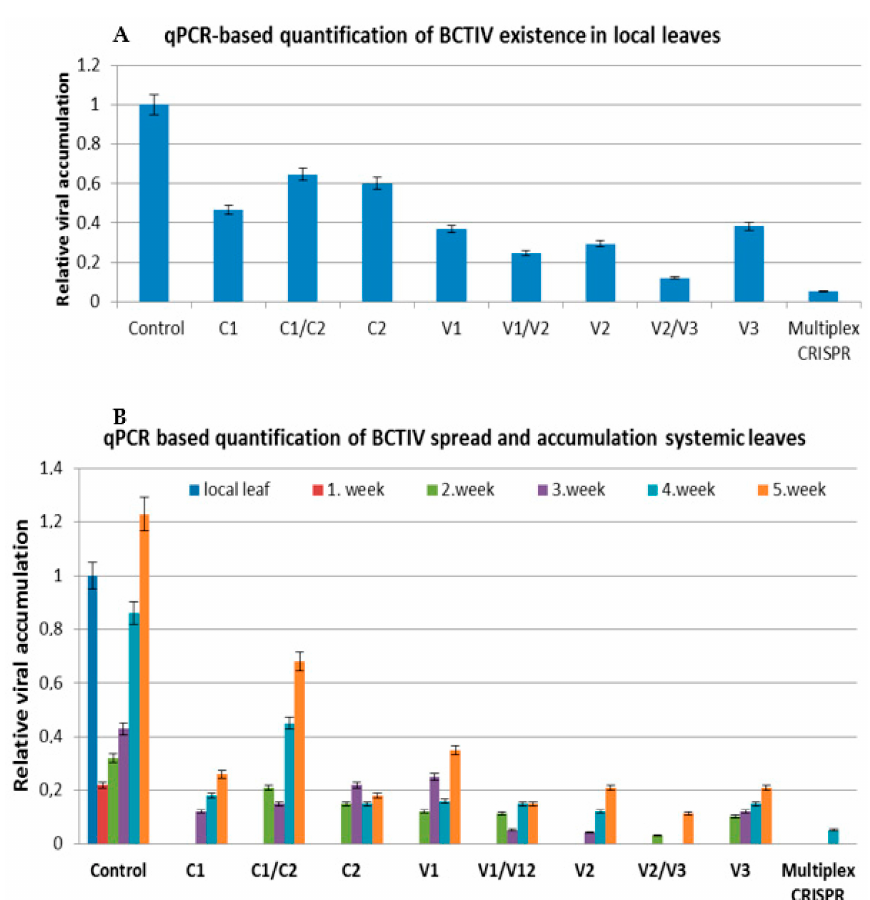
Figure 3. qPCR-based quantification of BCTIV content in gRNA/Cas9 and BCTIV co-agroinoculated local ( A ) and systemic leaves ( B ) in sugar beet. The viral accumulation was quantified according to the viral content of the local leaves in positive control sugar beets collected after the first week of agroinoculation.